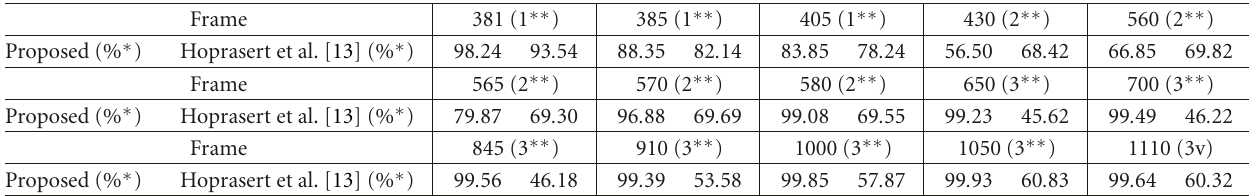
Figure 8: The results of global illumination changes with fluorescent lamps, the number below the picture is the index of frame, (a) original images, (b) the results of pixel classification, where red indicates the shadow, green indicates the highlight, and blue indicates the foreground, (c) the results of background subtraction with shadow removal using our proposed method, where dark indicates the background and white indicates the foreground. Table 4: The comparison between the proposed method and that proposed by Hoprasert et al. [13] via global illumination changes with fluorescent